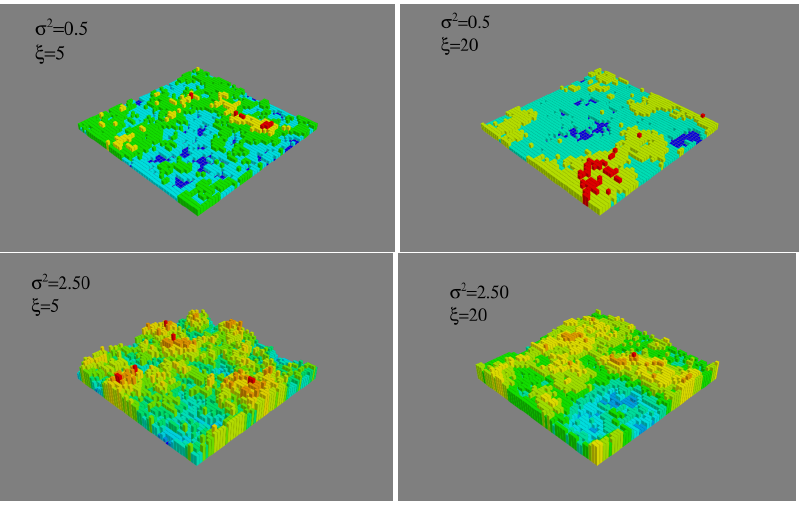
Figure 1. Random rough surfaces with σ 2 = 0.50, ξ = 5 ( top left ), σ 2 = 0.50, ξ = 20 ( top right ), σ 2 = 2.50, ξ = 5 ( bottom left ), σ 2 = 2.50, ξ = 20 ( bottom right